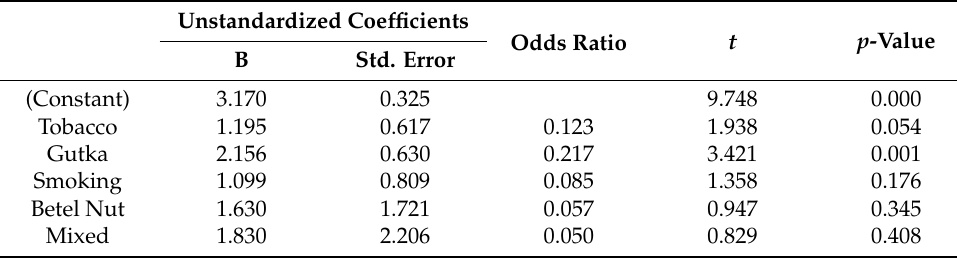
Table 6. Odds ratio—binary regression to predict the chances of higher DMFT scores among differ- ent